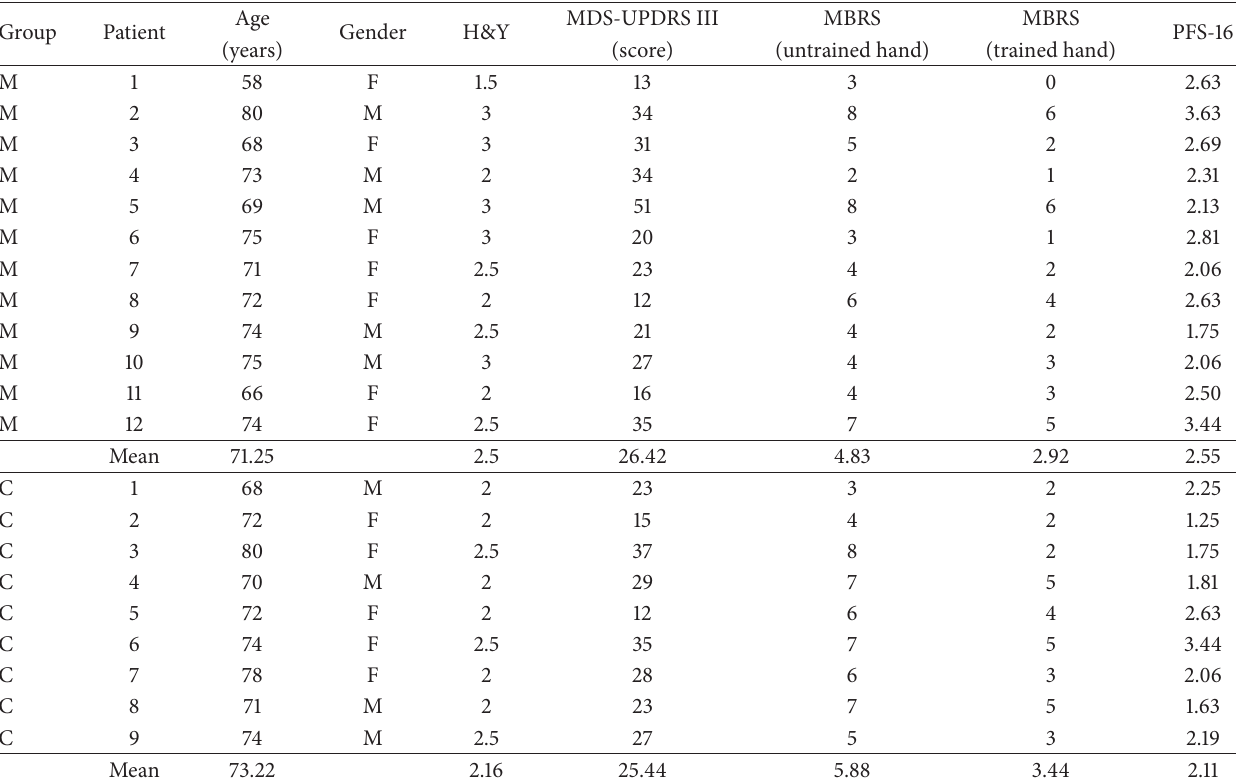
Table 1: Demographics and clinical characteristics of PD